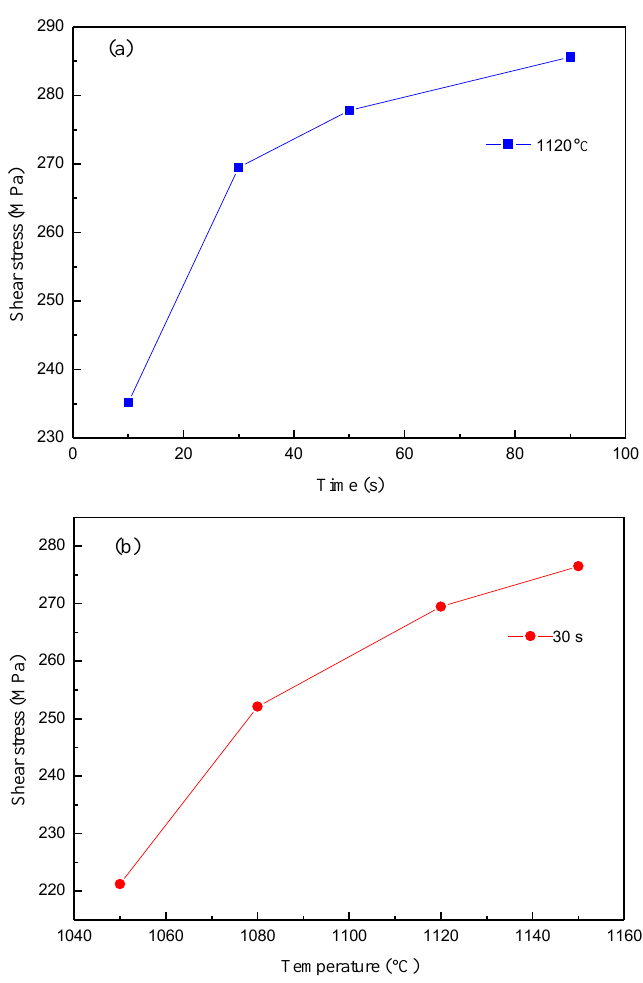
Figure 6. The shear test results of the brazed joints, ( a ) at 1120 °C, ( b ) for 30 s.